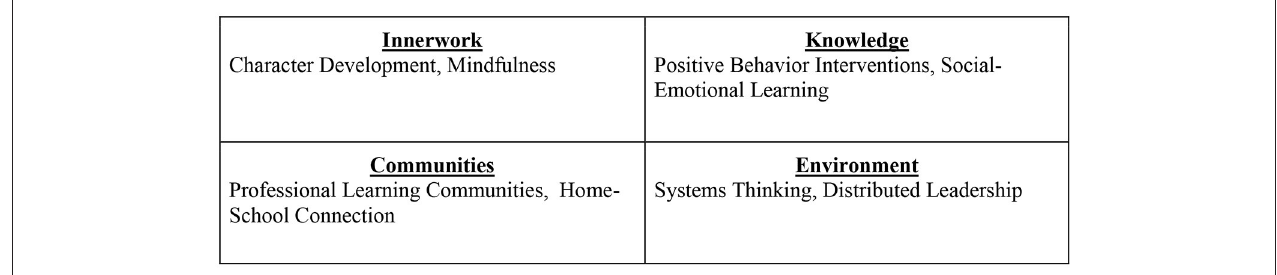
FIGURE 3 | Elements of the Integral Perspective of Peace Leadership in